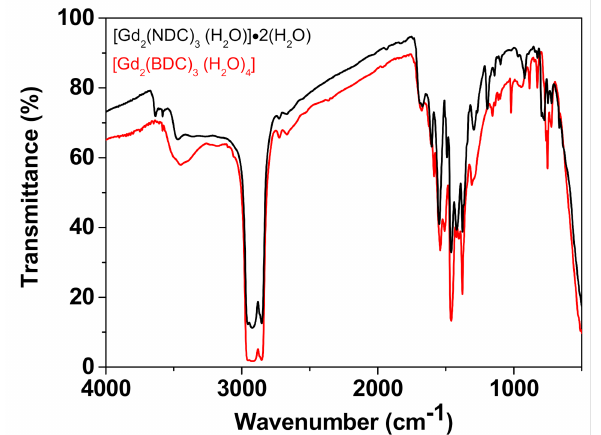
Figure 4. Comparison of the IR spectrum of the [Gd 2 (NDC) 3 (H 2 O)] · 2(H 2 O) vs. the spectrum of the [Gd 2 (BDC) 3 (H 2 O) 4